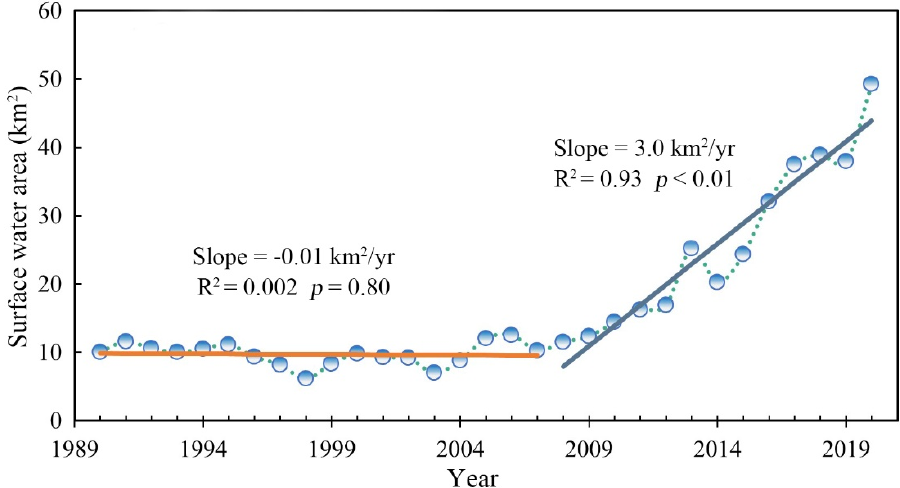
Figure 9. Change in total surface water area in Zhengzhou during 1990–2020.